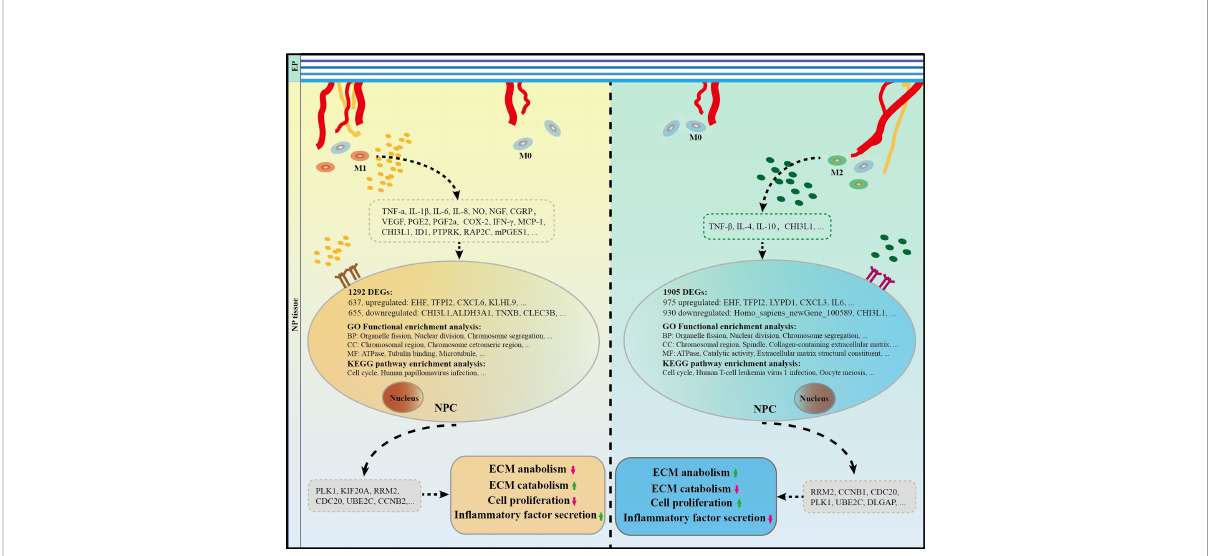
FIGURE 9 The role and potential mechanism of M1 and M2 macrophages in the process of IDD. Macrophages take part in IDD mainly in M1 and M2 polarization rather than macrophage themselves. Speci fi cally, M1CM inhibits cell proliferation and exacerbates IVD degeneration, while M2CM promote cell proliferation and attenuates IDD development. A total of 1038 DEGs were identi fi ed in M1CM treated NPCs, and 1905 DEGs in the M2CM group. Cell cycle was the most signi fi cant pathway enriched in KEGG enrichment, and organelle fi ssion, nuclear division, and chromosome segregation were highly enriched in GO functional enrichment in both treatment NPCs. Finally, the fi ve most signi fi cant genes in the M1CM group were PLK1, KIF20A, RRM2, CDC20, UBE2C and those in the M2CM groups were RRM2, CCNB1, CDC20, PLK1, and UBE2C. IDD, intervertebral disc degeneration; IVD, intervertebral